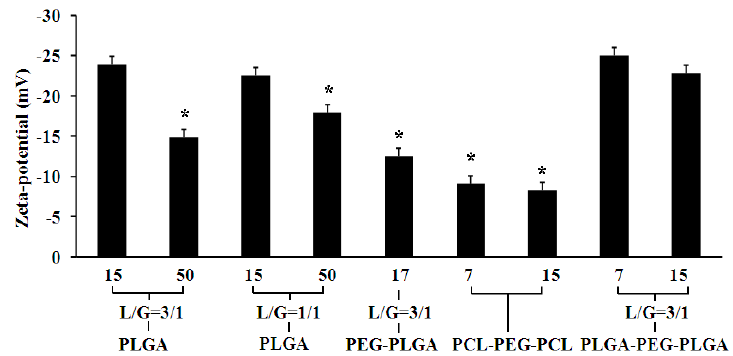
Figure 3. The effect of polymer types on the zeta-potential of Sal-LPNPs (mean ± SD, n = 3). * indicated there was significant difference ( p < 0.05) compared to PLGA-PEG-PLGA (KD) were shown on the X axis. L/G was the (15 KD) group. The polymer type and M W lactide/glycoside molar ratio in PLGA or polymers containing PLGA